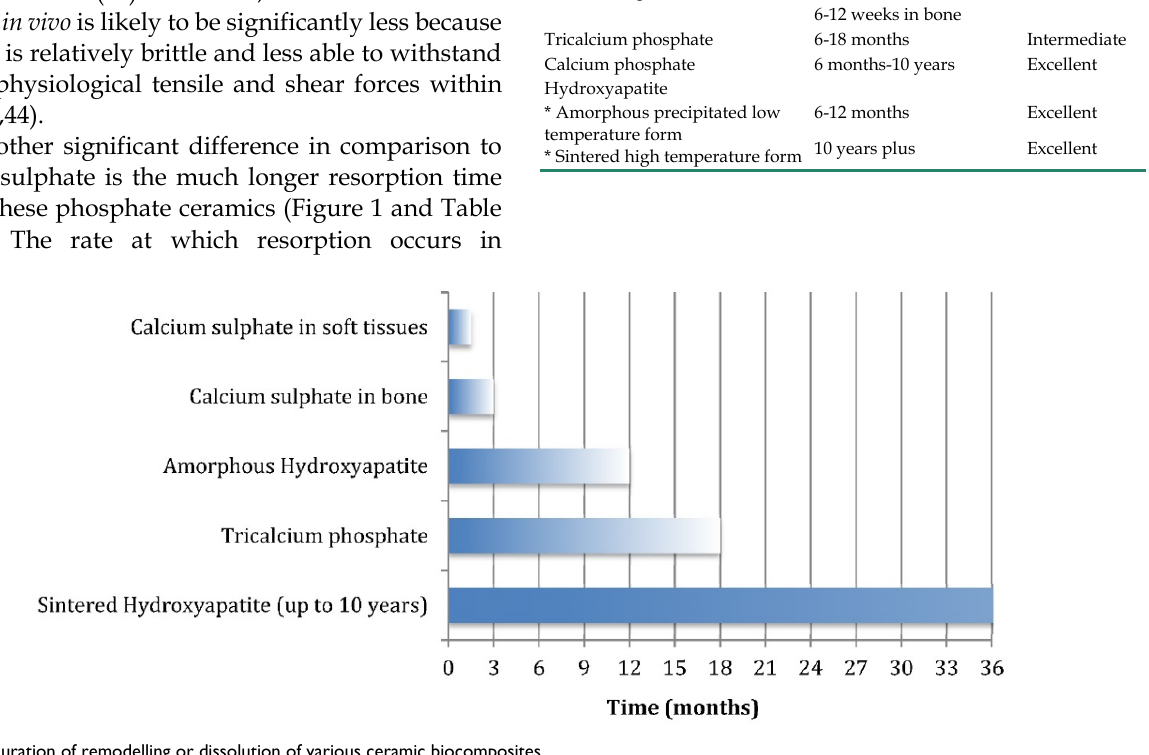
Figure 1. Duration of remodelling or dissolution of various ceramic